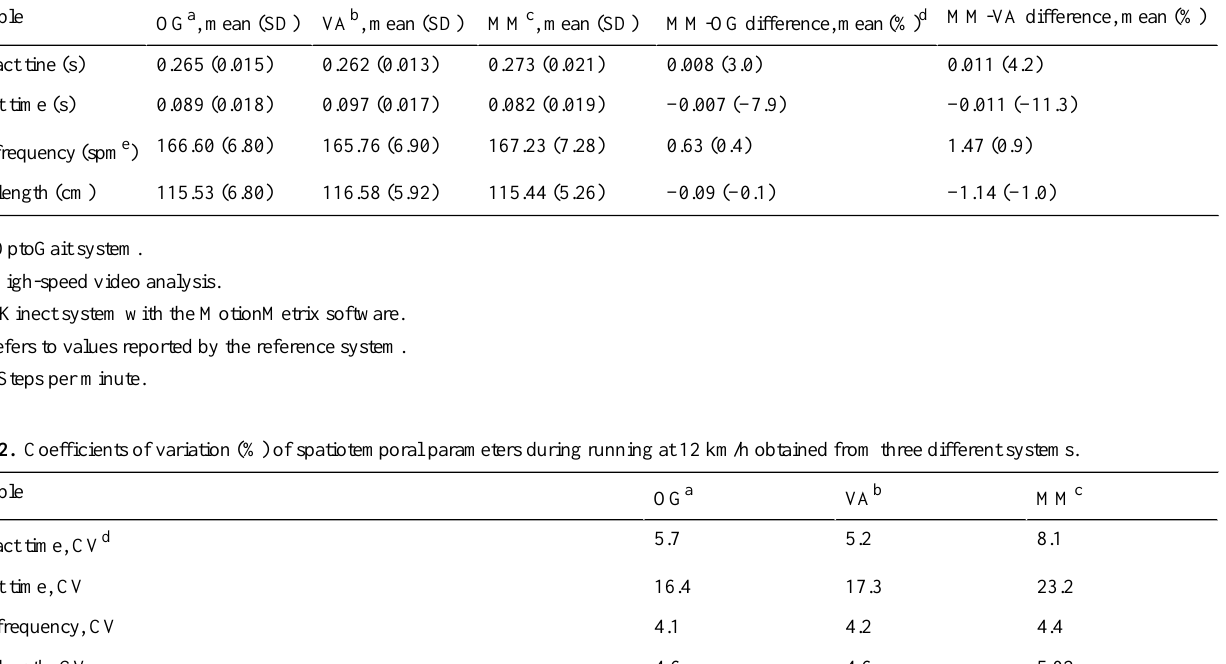
Table 1. Descriptive data of spatiotemporal parameters obtained from different systems (ie, Kinect with the MotionMetrix software, OptoGait, and high-speed video analysis at 1000 Hz).